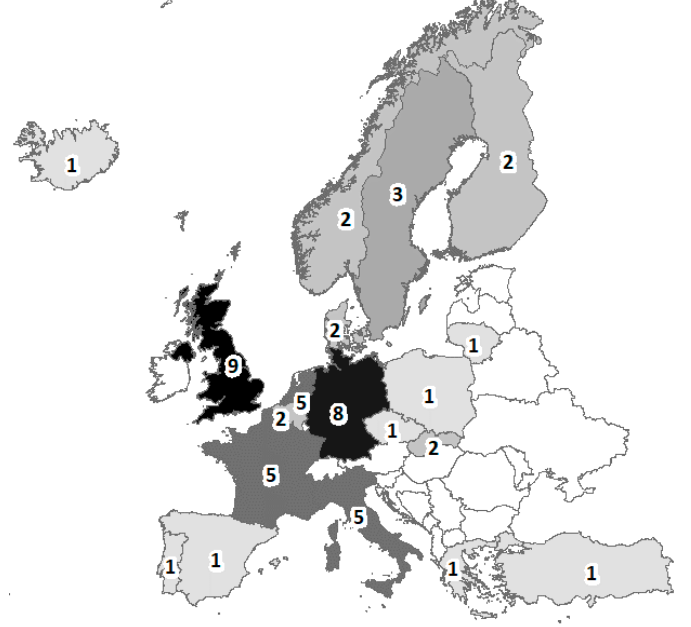
Figure 3. Location of the countries. The numbers refer to the number of times each country is represented in the 45 cohorts (the total is > 45 because of the multinational cohort, Europrevall). The darker the shading, the higher the numbers. Int. J. Environ. Res. Public Health 2020 , 17 , x